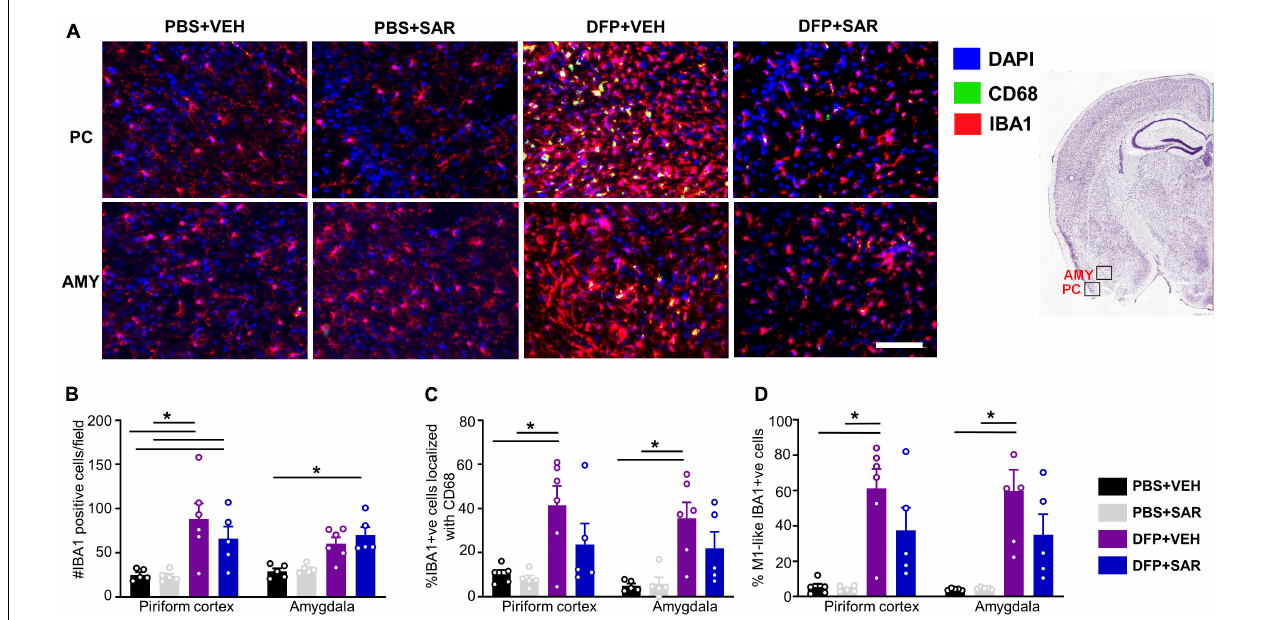
FIGURE 8 | Effects of SAR on DFP-induced microgliosis. (A) Representative images from the piriform cortex (PC) and amygdala (AMY) showing IBA1 and CD68 positive cells. (B,D) DFP induced significant upregulation of IBA1 positive cells (B) , IBA1 positive cells colocalized with Cd68 (C) and IBA1 positive cells with reactive (M1) like morphology (D) with non-significant mitigation by SAR (mixed measures ANOVA, n = 5-6). Mixed measures ANOVA, n = 5-6. Error bars indicate standard error of the mean. * p < 0.05. Area counted = 0.14 mm 2 Atlas Image credit: Allen Institute, United States.